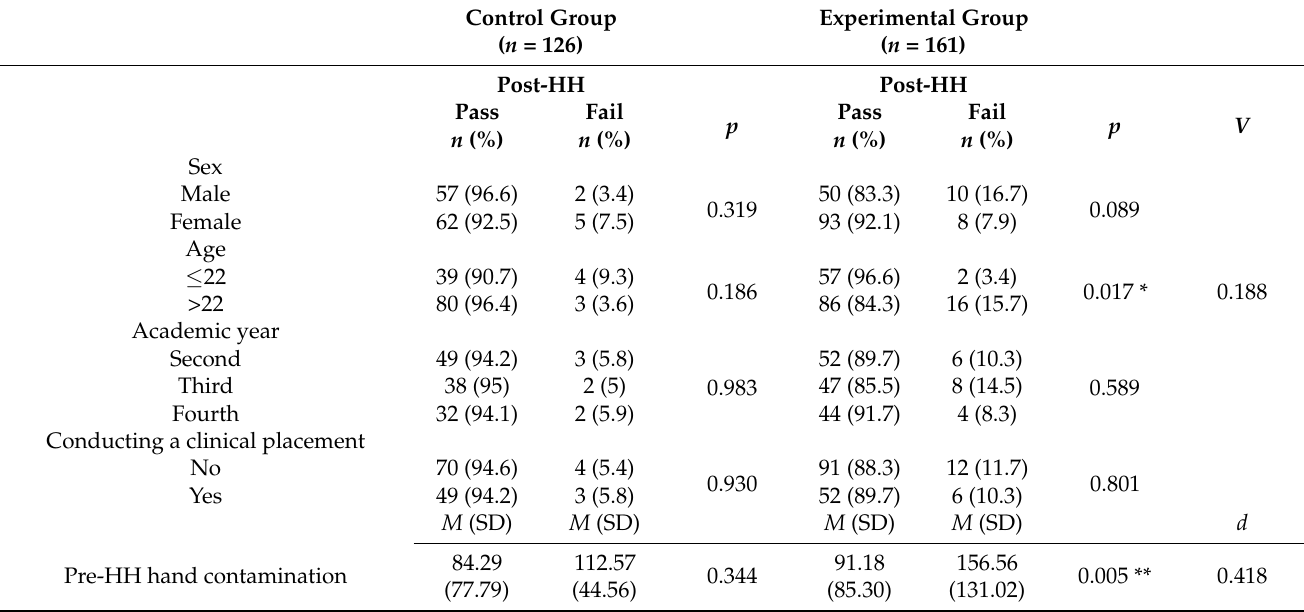
Table 4. Post-HH data: comparisons based on sociodemographic and academic